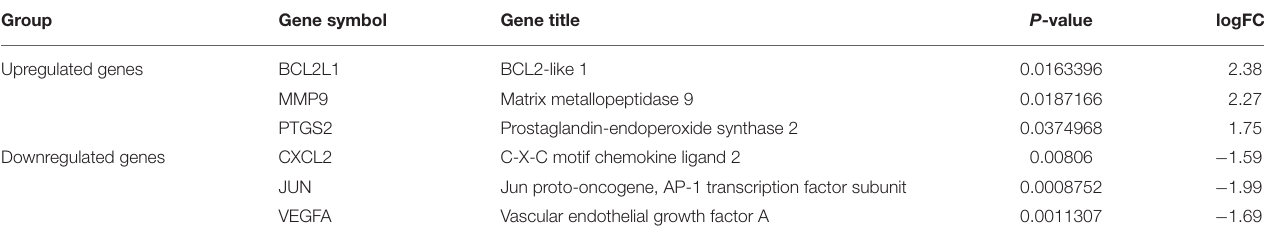
TABLE 2 | Differentially expressed genes (DEGs) that overlapped with potential therapeutic targets of Xuefu Zhuyu decoration (XFZYD). Group Gene